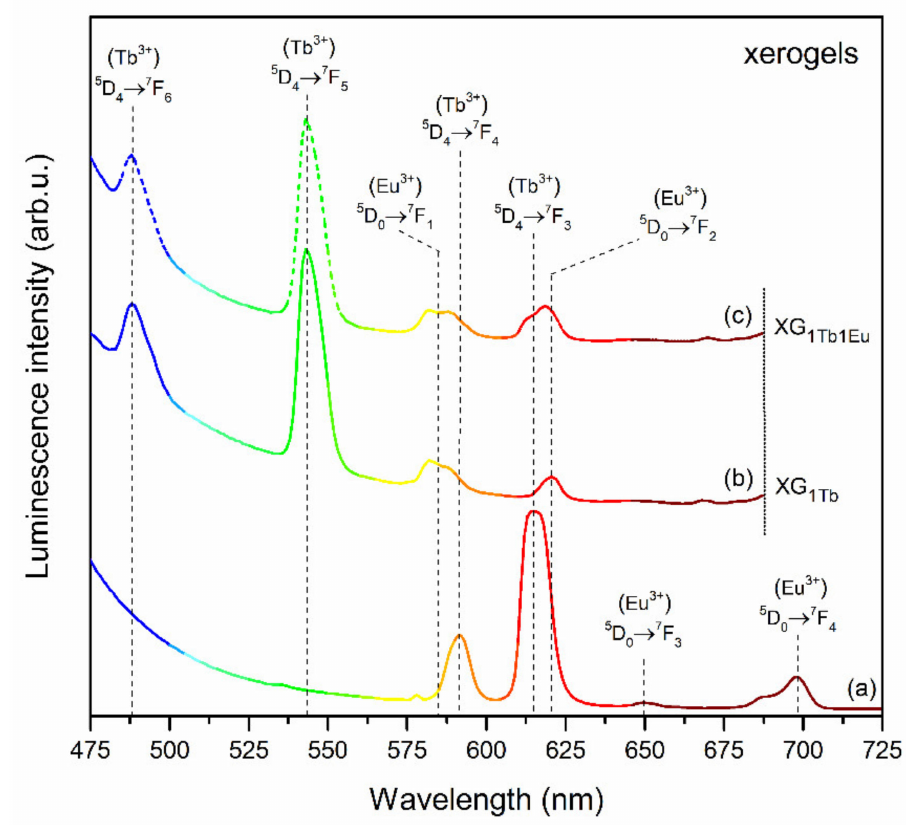
Figure 7. Emission spectra of: ( a ) XG 1Tb1Eu ( λ exc = 395), ( b ) XG 1Tb ( λ exc = 351), and ( c ) XG 1Tb1Eu ( λ exc = 351